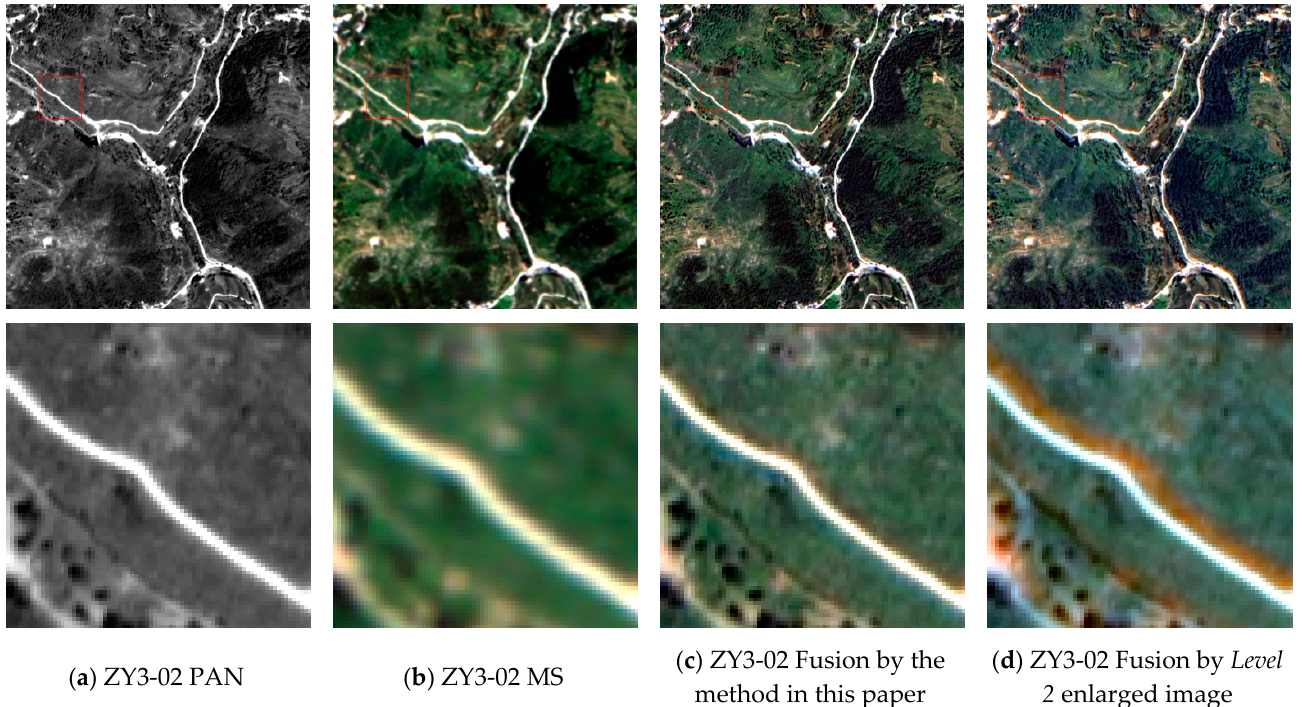
Figure 8. Comparison of the ZY3-02 fusion image created using the method in this paper and the fusion image created using the Level 2 PAN and MS enlarged image. ( a ) PAN image; ( b ) enlarged MS image; ( c ) fusion image created using the method in this paper; ( d ) fusion image created using the enlarged Level 2 image.